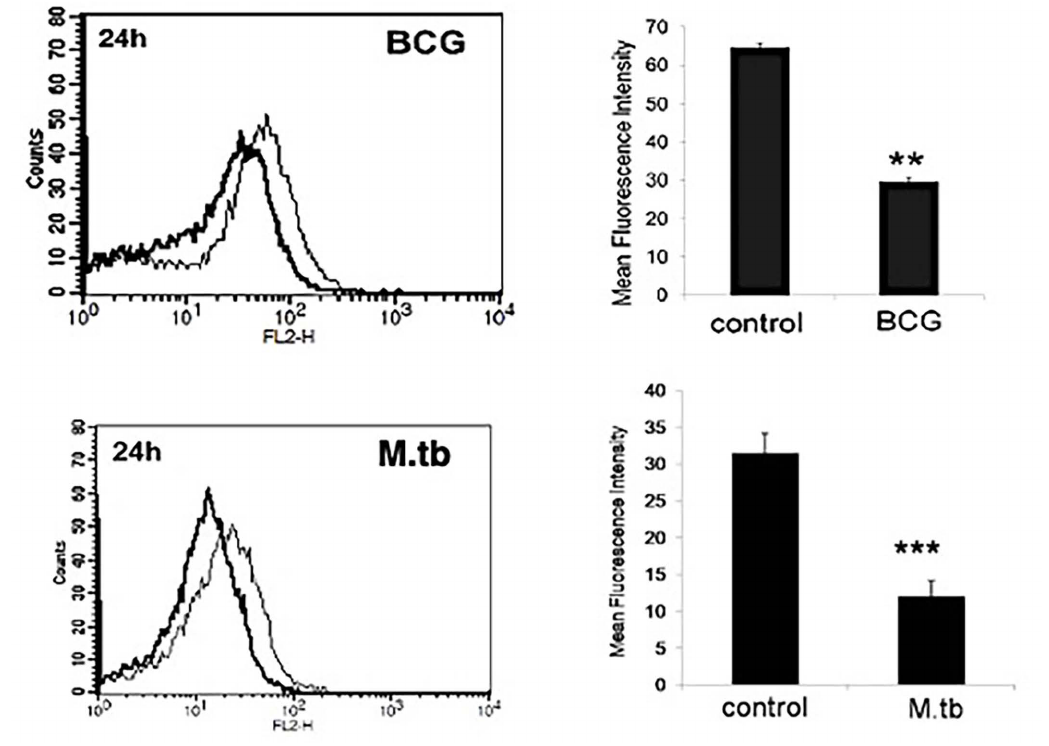
Figure 1 : M. bovis BCG and M. tb H37Rv downregulate IFN-γR expression on macrophages. Monocytic THP-1 cells were incubated with 50ng/ ml PMA for 16h for differentiation into macrophages. Following this, cells were infected with either M. bovis BCG or M. tb H37Rv at 2MOI for 24h and IFN-γR was monitored using flow cytometry. Thin lines represent expression levels in uninfected controls whereas bold lines in the histograms represent level of expression after infection. Adjacent bar graphs summarize the mean fluorescence intensity values (MFI). p values, *p<0.05 and **p<0.01 and ***p<0.001, were ascertained using Student’s t -test. Data are expressed as mean ± S.D.,